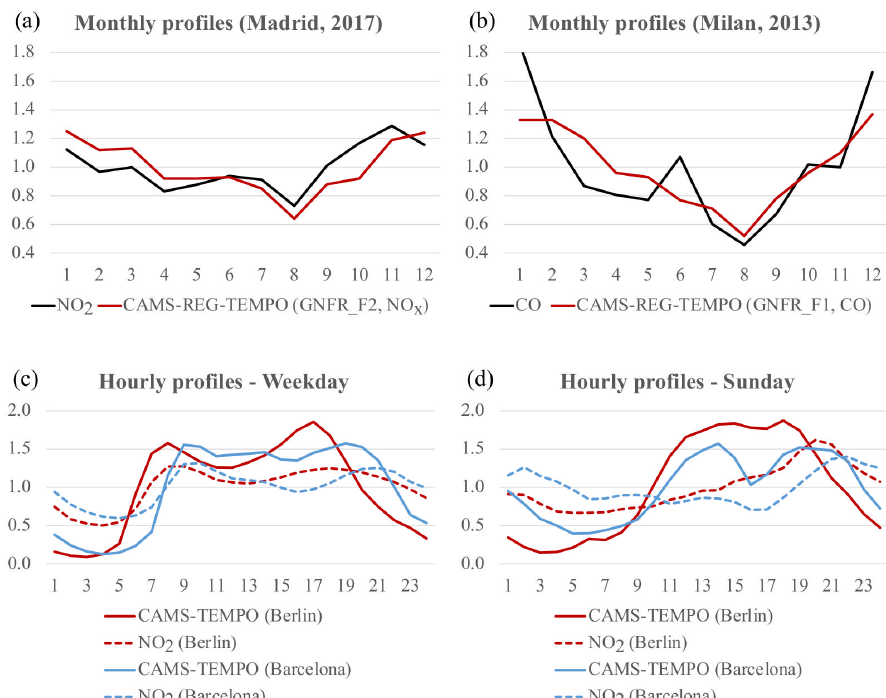
Figure 11. Comparison between monthly variations of CAMS-REG-TEMPO profiles for NO x diesel exhaust emissions (GNFR_F2) and measured NO 2 concentrations for the city of Madrid during 2017 (a) . Comparison between monthly variations of the CAMS-REG-TEMPO profile for CO gasoline exhaust emissions (GNFR_F1) and measured CO concentrations for the city of Milan during 2013 (b) . Hourly variation of CAMS-TEMPO GNFR_F profiles and NO 2 concentrations during weekdays (c) and Sundays (d) for the cities of Barcelona and